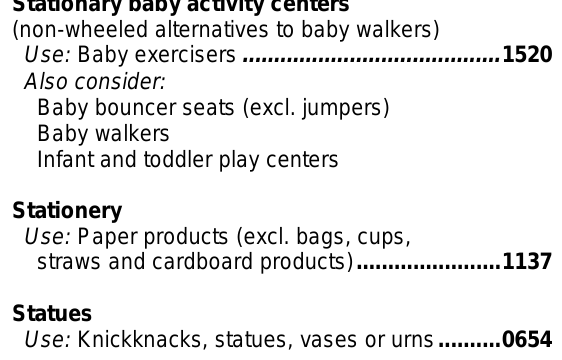
Stickball Use: Other ball sports (activity/apparel/ Stickers Use: Paper products (excl. bags, cups, Sticks, nunchuka Use: Martial arts (activity/apparel/equipment) .... 3257 Sticks, swizzle Use: Bars and bar accessories